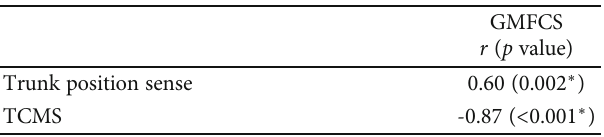
Table 4: Correlation between trunk position sense and TCMS with GMFCS levels ( n = 24